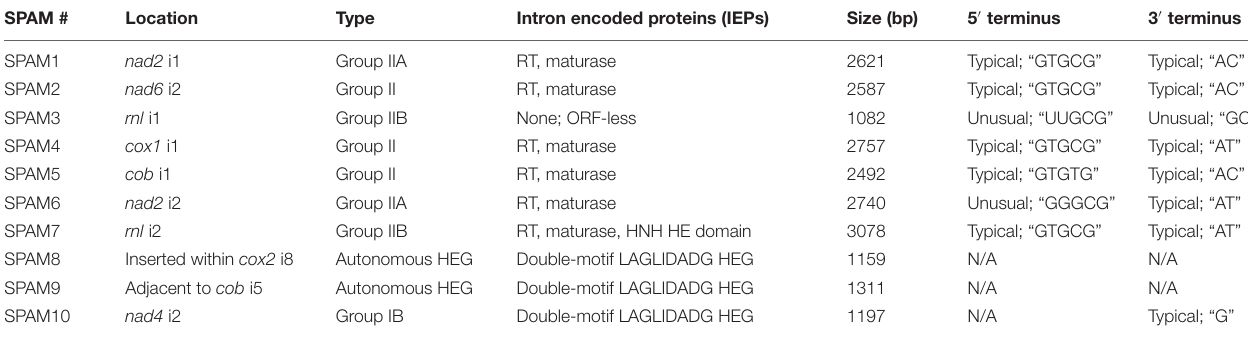
TABLE 3 | Location and characteristics of 10 mobile mitochondrial elements (SPAMs) found in Ceratocystis lukuohia and Ceratocystis huliohia